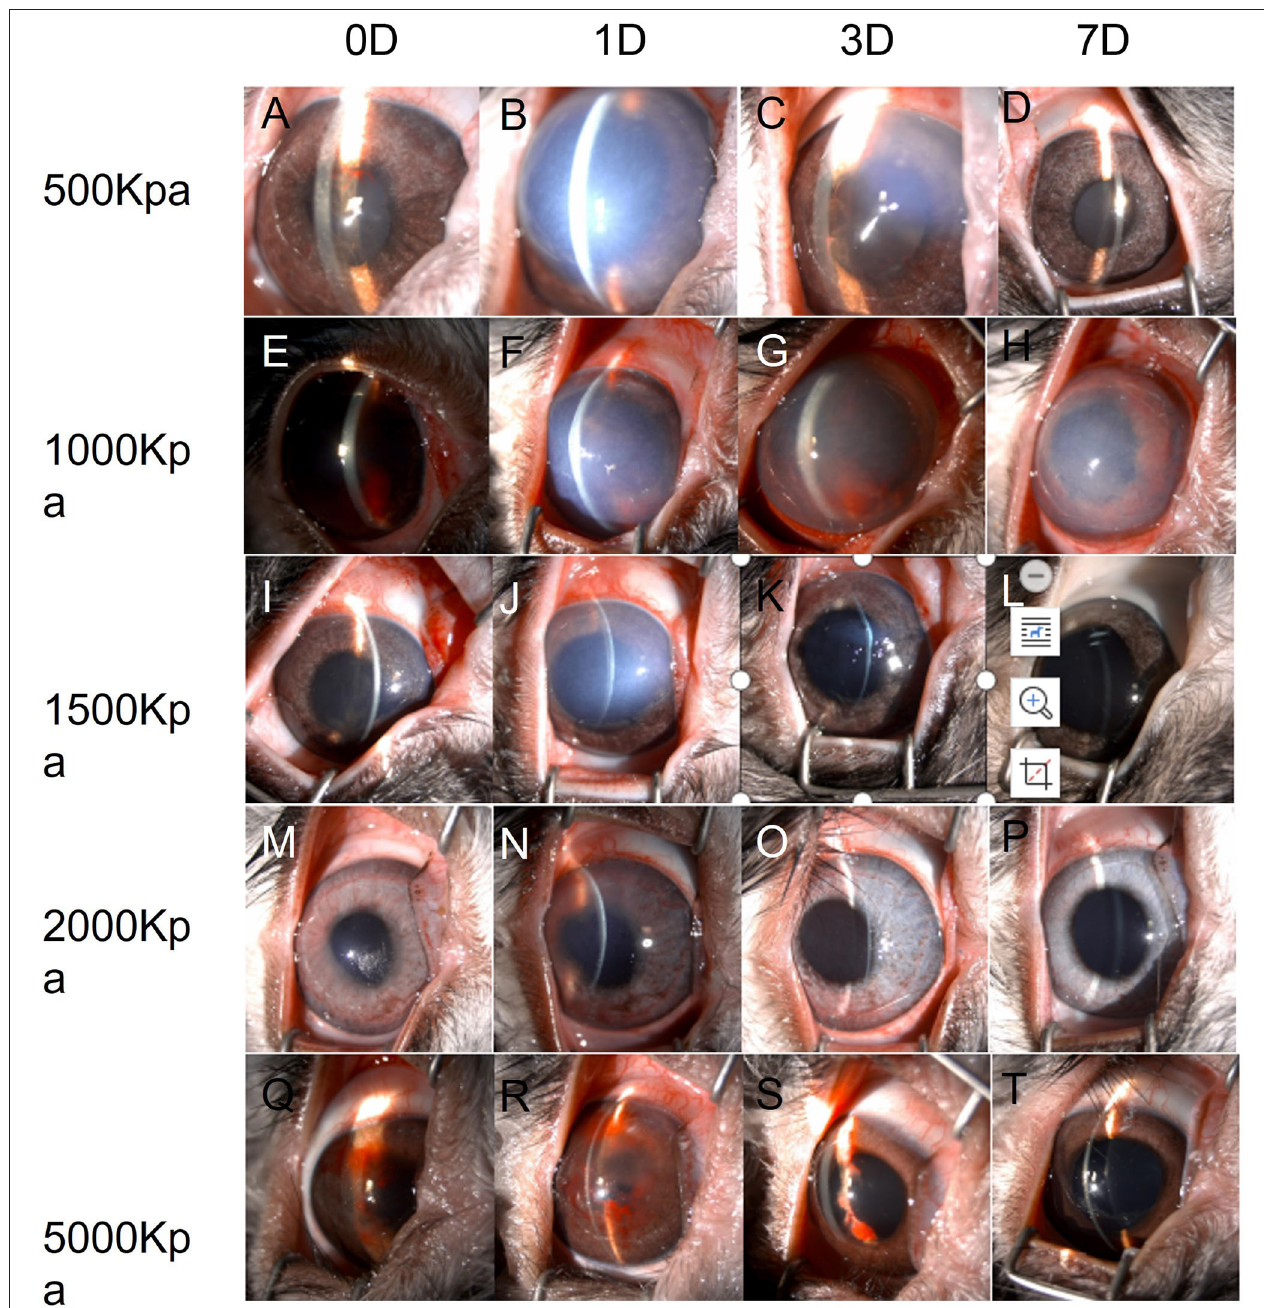
FIGURE 2 | Changes of eyes exposed to different pressure examined by slit lamp chronologically. (A–D) : Changes of eyes exposed to 500 Kpa. (A) Minor hyphema combined with corneal lesion on day 0. (B) Corneal opacity at day 1 (C) Corneal edema was ameliorated at day 3. (D) Transparent cornea and anterior chamber at day 7. (E–H) : Changes of eyes exposed to 1,000 Kpa. (E) Moderate hyphema combined with corneal lesion on day 0. (F) Corneal opacity at day 1. (G) Corneal edema was ameliorated, and blood-fluid level occurred at day 3. (H) Slightly residual cornea edema and clear anterior chamber with irregularly dilated pupil at day 7. (I–L) Changes of eyes exposed to 1,500 Kpa. I. Minor corneal edema on day 0. (J) Moderate corneal opacity at day 1. (K) Transparent corneal with dilated pupil at day 3. (L) Transparent corneal with dilated pupil at day 7. (M–P) Changes of eyes exposed to 2,000 Kpa. (M) Minor corneal lesion with scattered hyphema on day 0. (N) Moderate corneal lesion with lightly scattered hyphema at day 1. (O) Minor corneal edema at day 3. (P) Transparent corneal at day 7. (R–T) Changes of eyes exposed to 5,000 Kpa. (Q) Minor corneal lesion with severe hyphema on day 0. (R) Enlarged corneal edema with hyphema attached to the corneal endothelium at day 1. S. Minor corneal edema at day 3 with residual hyphema. (T) Transparent corneal with dilated pupil at day 7.